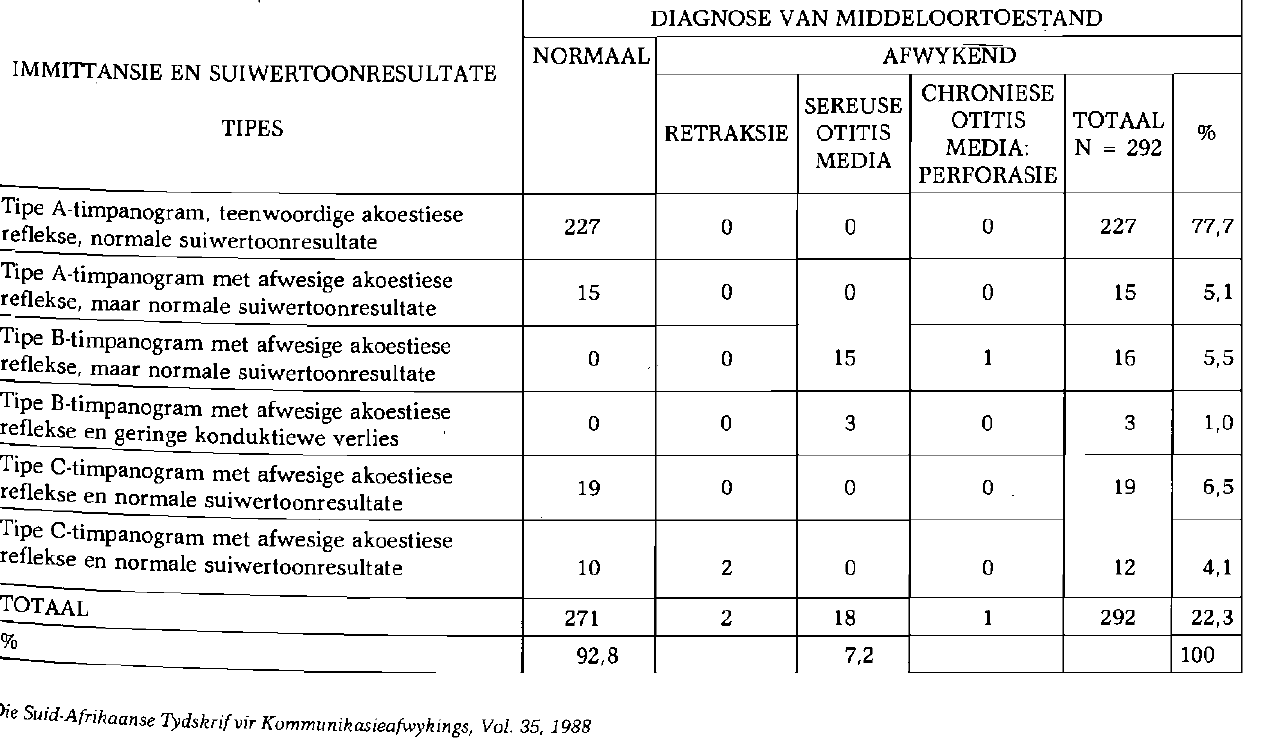
Tabel 3: Die otologiese diagnose in vergelyking met die oudiometriese siftingsresultate DIAGNOSE VAN MIDDELOORTOESTAND NORMAAL AFWYKEND IMMITTANSIE EN SUIWERTOONRESULTATE IMMITTANSIE EN SUIWERTOONRESULTATE IMMITTANSIE EN SUIWERTOONRESULTATE TIPES TIPES TIPES